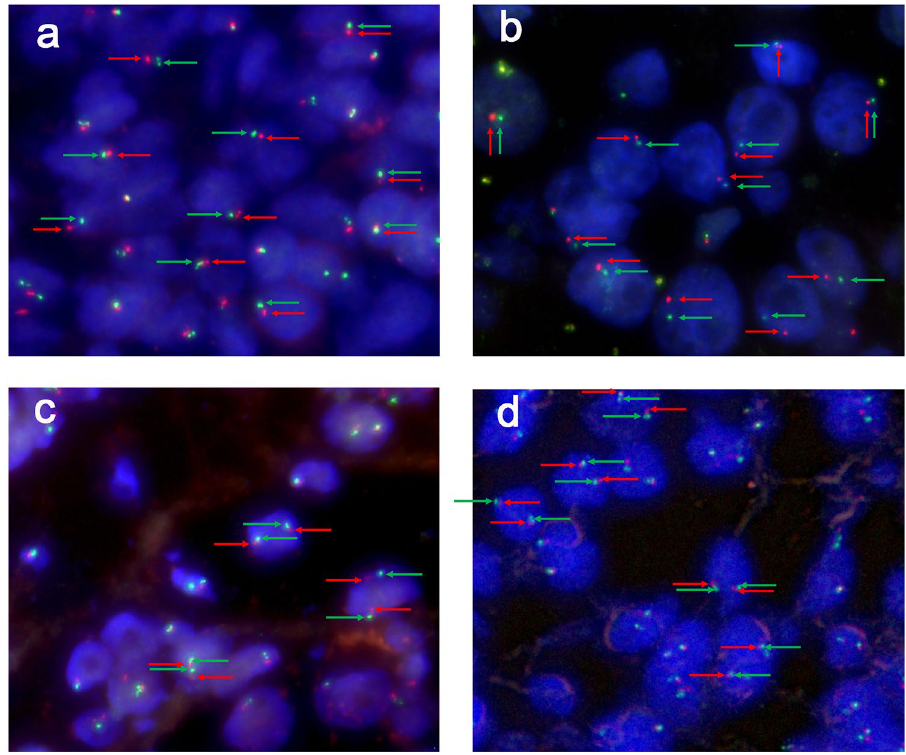
Figure 4. ( a , b ) show typical negative results of NONO-TFE3 dual-fusion FISH assay in males (1G1R, red and green arrowheads); ( c , d ) show typical negative results of NONO-TFE3 dual-fusion FISH assay in females (2G2R, red and green arrowheads).